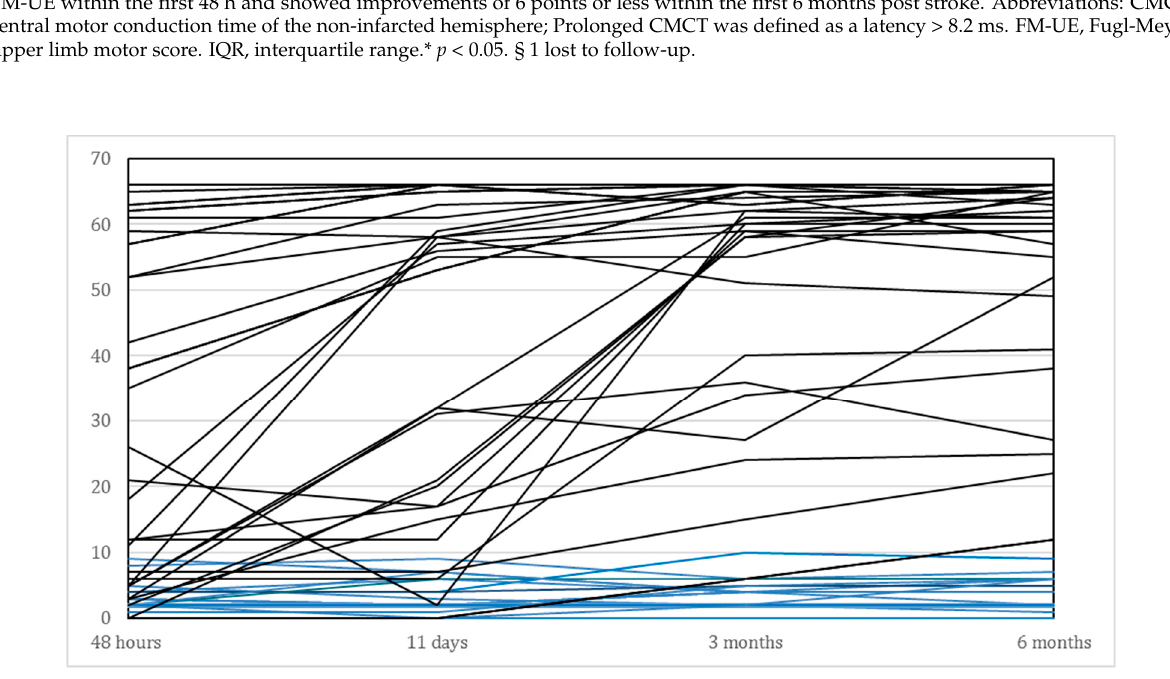
Figure 2. Time course of individual FM-UE scores for the affected upper limb of all patients ( N = 50), between baseline (i.e., within 48 h after stroke) and 6 months post stroke. Blue lines represent the non-recoverers ( N = 17) and black lines those who showed spontaneous neurological recovery ( N = 33). Table 2. Transcranial Magnetic Stimulation and Fugl-Meyer upper extremity score characteristics for the total group ( N = 50, second column), and subgroups (third and fourth columns) in relation to spontaneous neurological upper limb motor recovery after stroke.